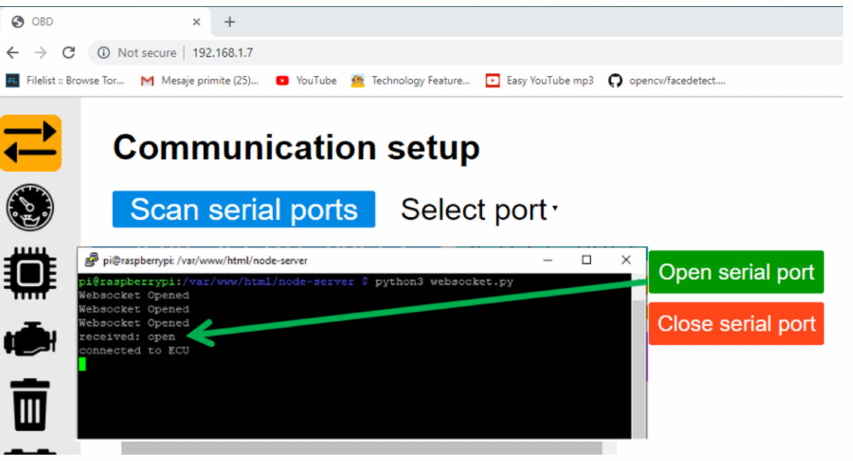
Figure 14. When the communication button is hinted, a scan action is executed, and the status result is displayed.